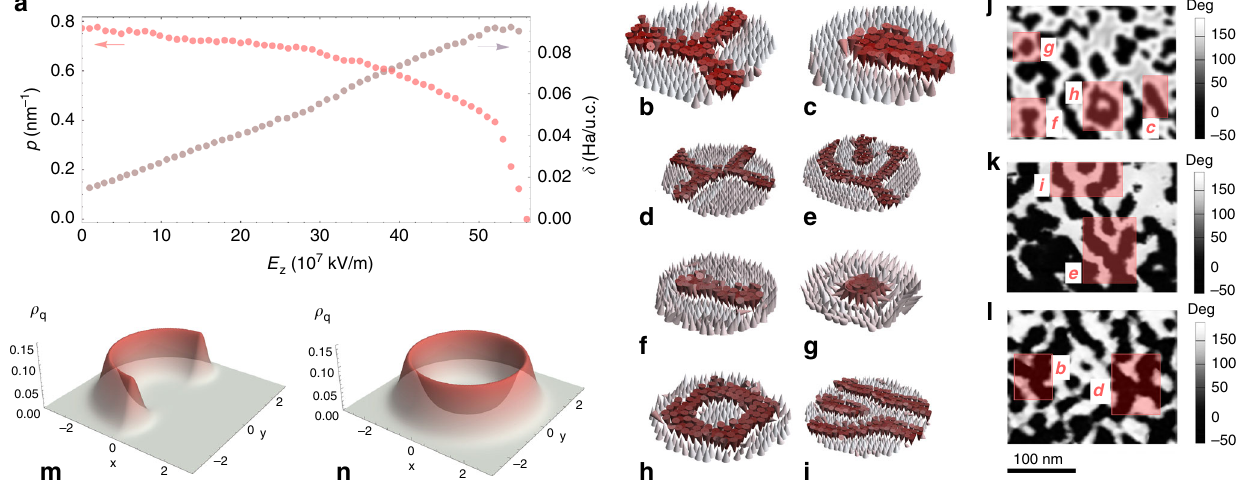
Fig. 3 Energetics and topology of domain patterns. a Purple curve corresponds to the evolution with increasing fi eld magnitude of the excess interfacial energy at 10 K, δ , taken as the difference between average energy of unit cells located at domain walls and unit cells belonging to the minority phase domains. Red curve corresponds to the evolution with increasing fi eld magnitude of the average interfacial length, or perimeter p . b , c show the elementary topological defects within the predicted dipolar modulated phases in the middle layer of Pb(Zr 0.4 Ti 0.6 )O 3 80 × 80 × 5 thin fi lm at 10 K, namely, the concave disclination (threefold junction or antimeron) and the convex disclination (meron), respectively. Different combinations of these elementary defects lead to composite defects such as d the saddle or fourfold junction (superposition of two concave disclinations), e the handle (pair of nearby concave and convex disclinations), f the bimeron (elongated skyrmion or superposition of two convex disclinations), g the skyrmion, h the target skyrmion, and i the dislocation. j , k show experimental PFM phase images of PZT fi lms with 1 unit cells STO spacer. Domain structures were acquired after ( j ) scanning the as-grown